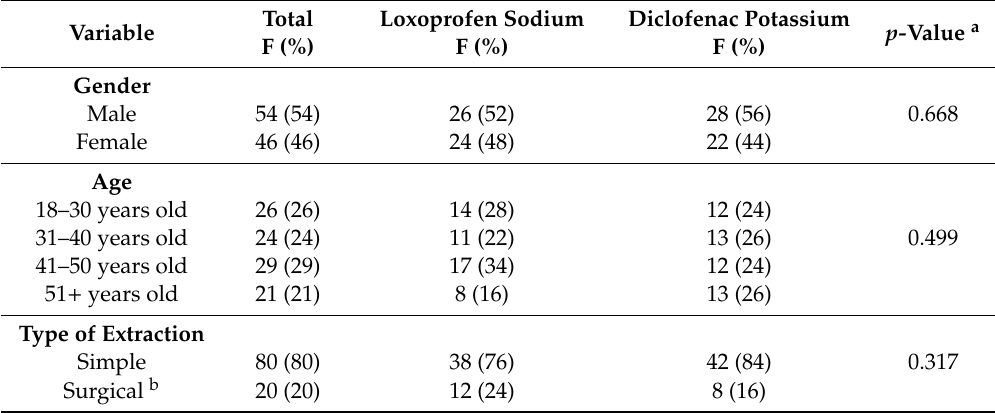
Table 1. Characteristics of the partcipants ( n =